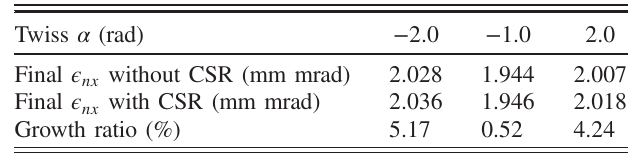
TABLE IV. Final normalized emittance from the achromatic dog-leg transfer line obtained while taking higher-order terms into consideration. Before entering the dog-leg transfer line, the initial beam emittance was 1.936 mm mrad. The initial Twiss β function is fixed at 0.1 m. The emittance growth ratio is estimated relative to the initial